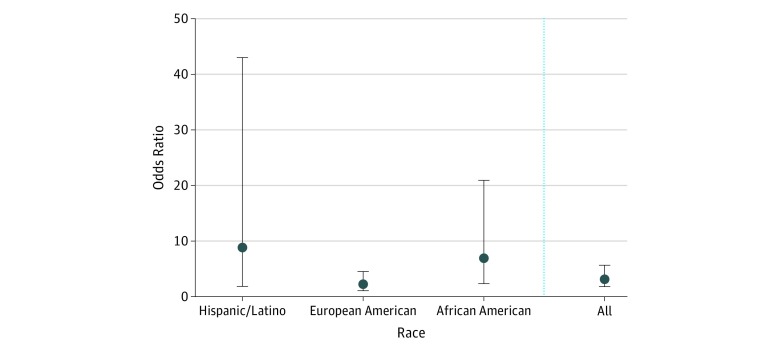
The Odds of a Proband With Early-Onset Atrial Fibrillation Having a Reported Family History of Atrial Fibrillation Compared With Patients With Non–Early-Onset Atrial Fibrillation Across 3 Racial and Ethnic Groups Odds ratios with Wald 95% CIs (error bars) are shown. The dotted blue line separates the odds ratios for each individual race from the 3 races combined.